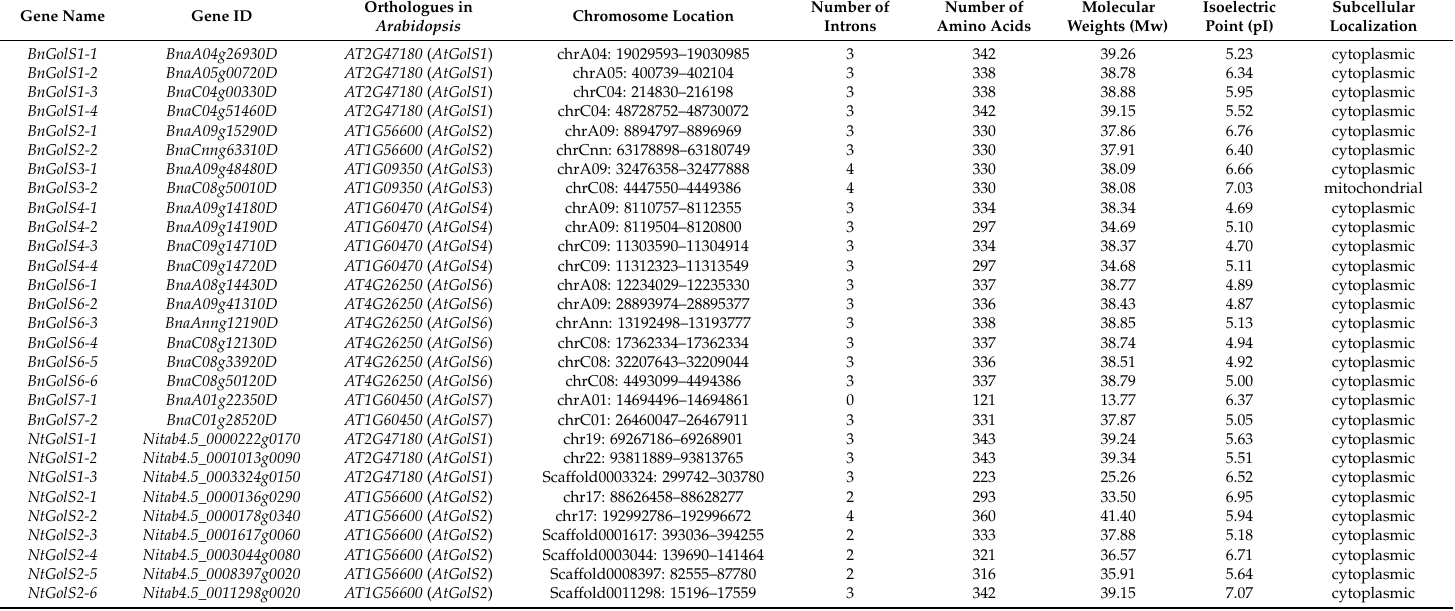
Table 1. Characteristics of the twenty BnGolS and nine NtGolS proteins identified in this